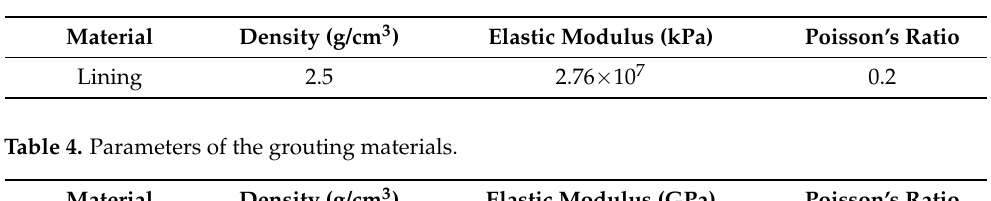
Table 3. Parameters of the lining.